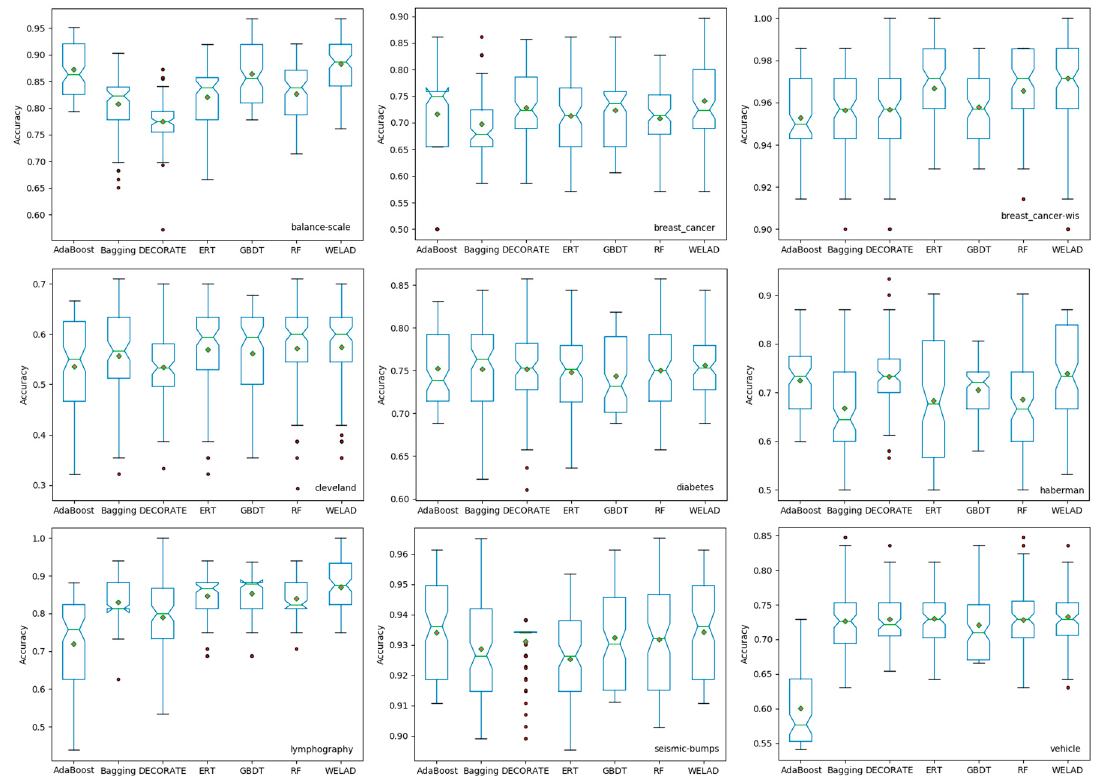
Figure 4. Boxplots of the performances of the compared algorithms on 9 selected datasets.